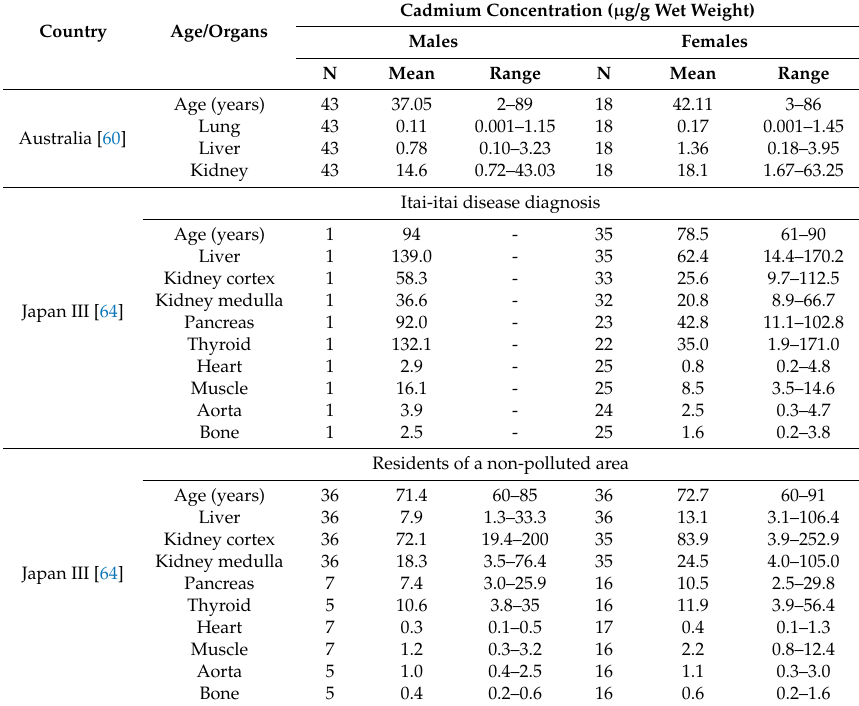
Table 2. Gender differences in levels of cadmium